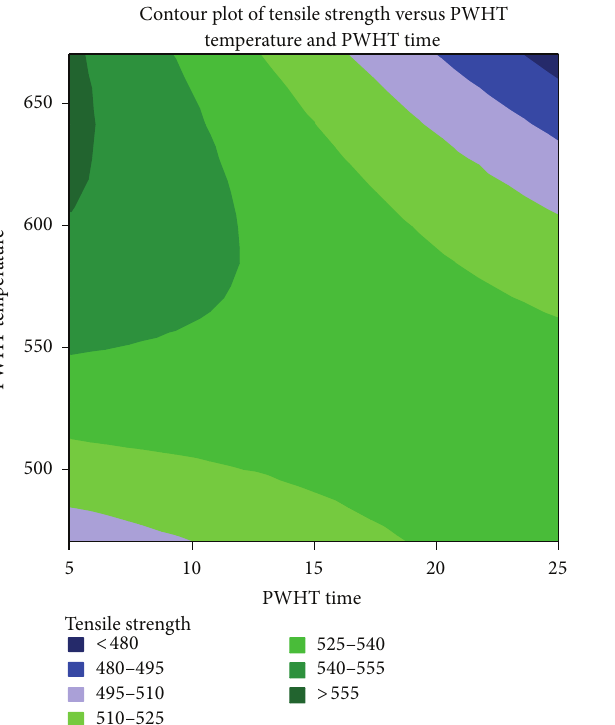
Figure 3: Response surface plots of PWHT time and PWHT temperature for tensile